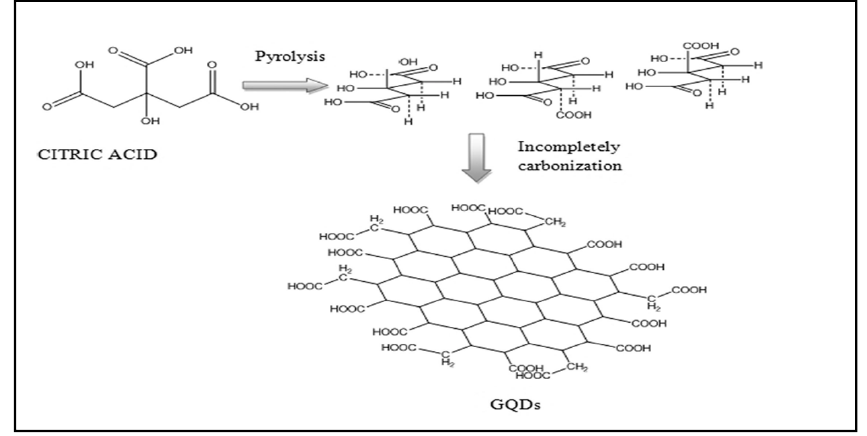
Figure 11. Preparation of GQDs from pyrolysis of citric acid (reprinted from [114], Copyright Wiley-vch, 2018).